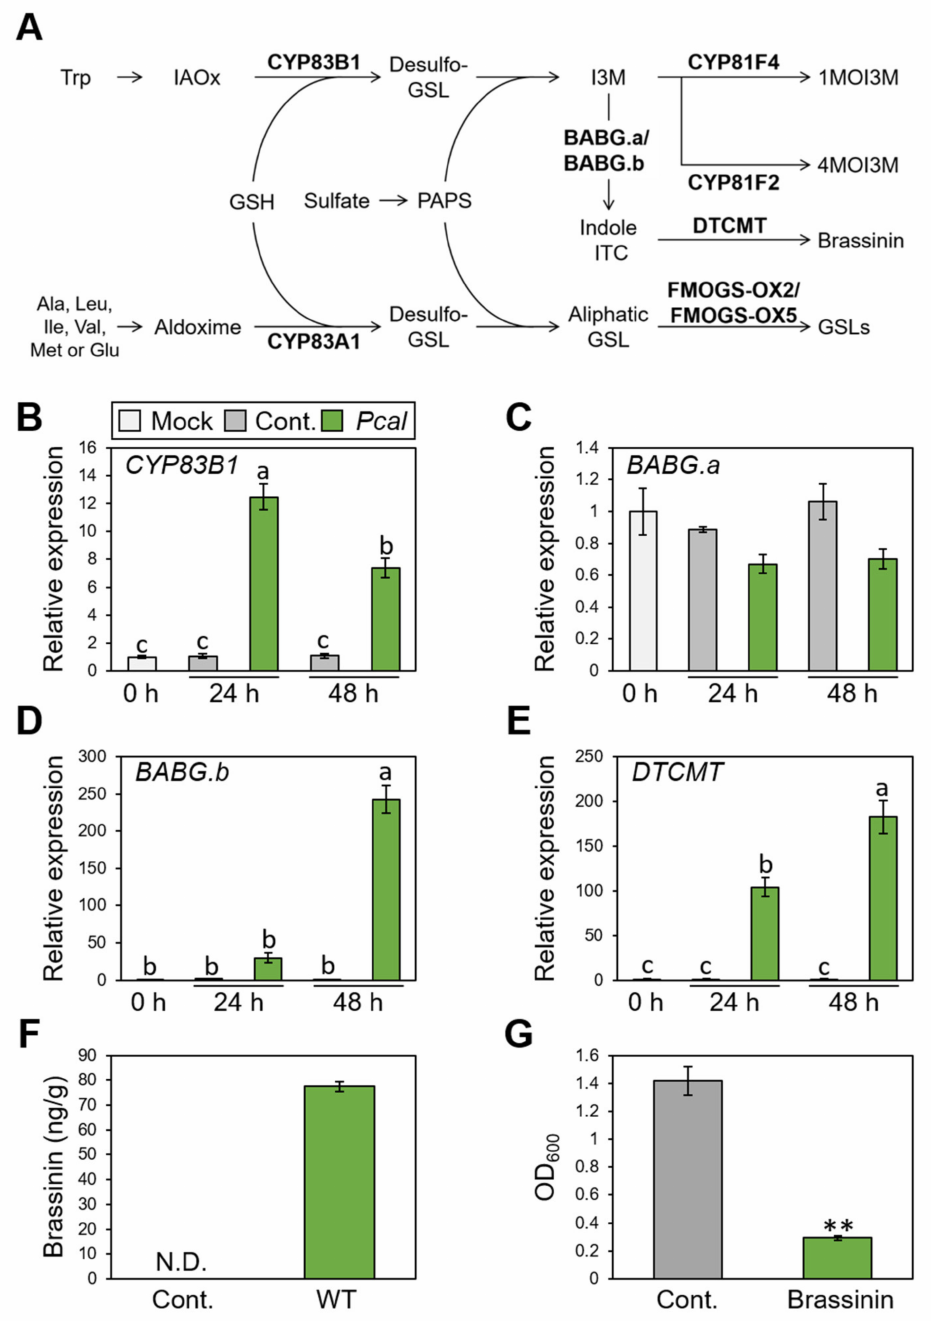
Figure 2. Expression profiles of brassinin-related genes and brassinin production during Pseudomonas cannabina pv. alisalensis KB211 WT infection, and antimicrobial activity of brassinin. ( A ) The aliphatic and indolic glucosinolate biosynthesis pathways in cabbage. Schemic biosynthetic pathways with the specific biosynthetic enzyme locations used in this study are shown in bold. GSH,